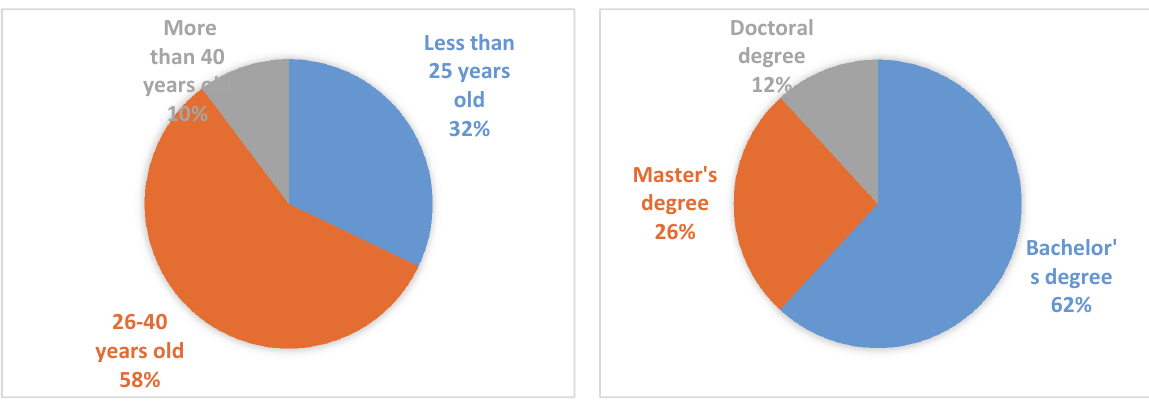
Fig. 4. Age distribution chart Fig. 5. Educational level distribution chart